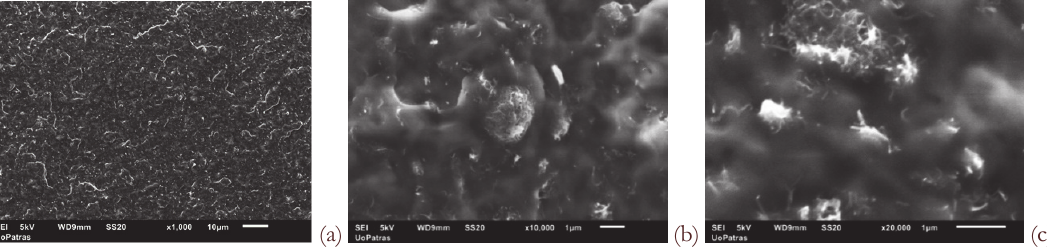
Figure 5: SEM photos of an area in the MWCNT/PP 5 wt%_03 specimen: a. x1,000, b. x10,000 and c. x20,000. For the SEM tests two specimens were selected from each of the 2 wt% and 5 wt% materials, namely the MWCNT/PP 2 wt%_03, MWCNT/PP 2 wt%_04, MWCNT/PP 5 wt%_01 and MWCNT/PP 5 wt%_03 specimens. The selection